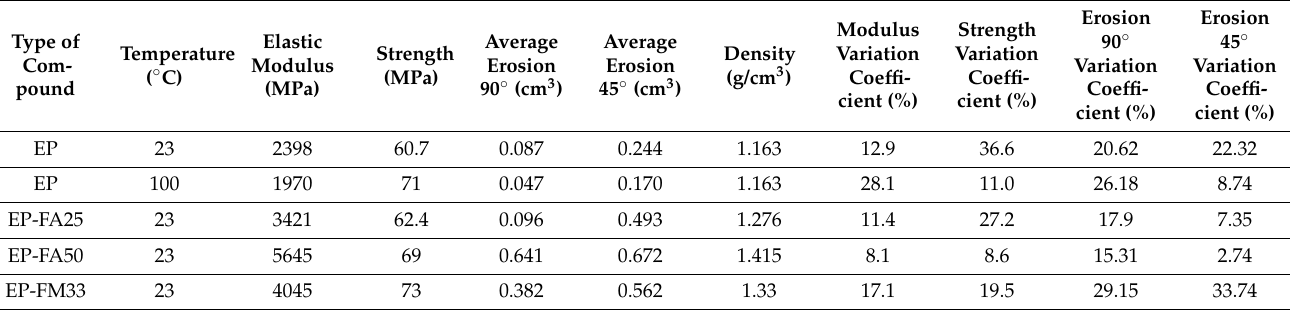
Table 3. Summary of bend and wear test